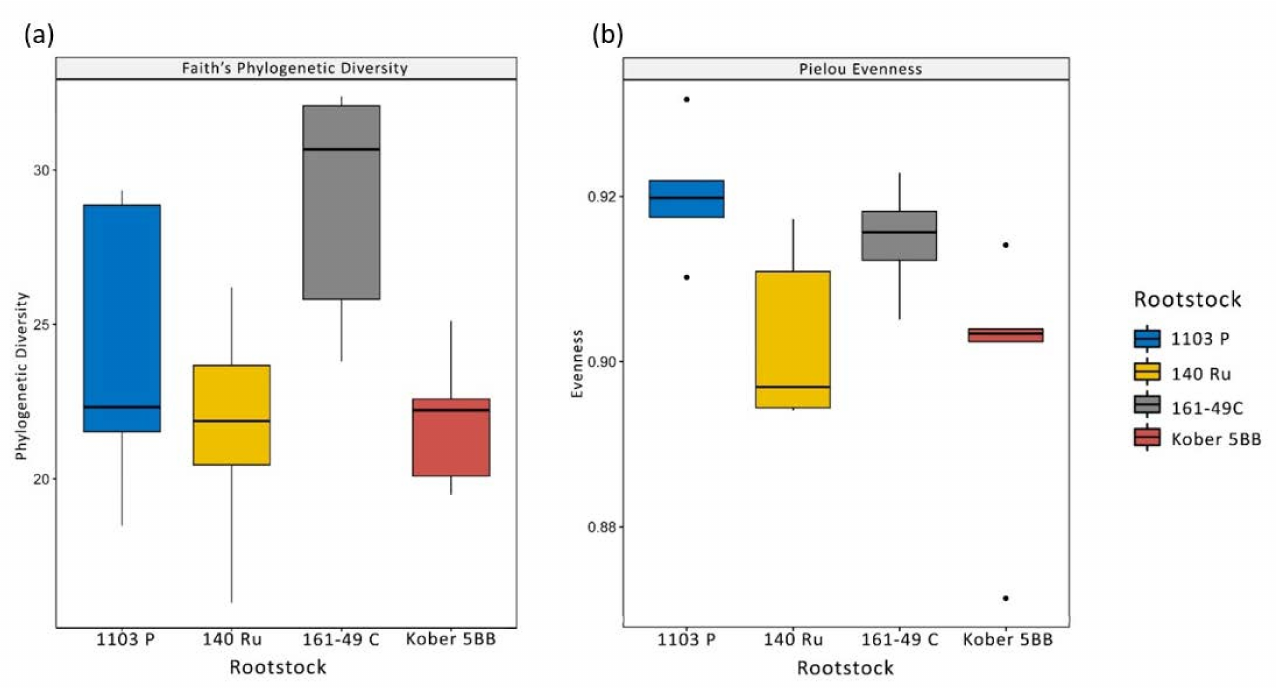
Figure 2. Boxplots reporting the results of alpha diversity analysis. ( a ) Faith’s phylogenetic plot showing similar values for the four rootstocks. ( b ) Pielou’s evenness plot showing values higher than 0.895 for all the